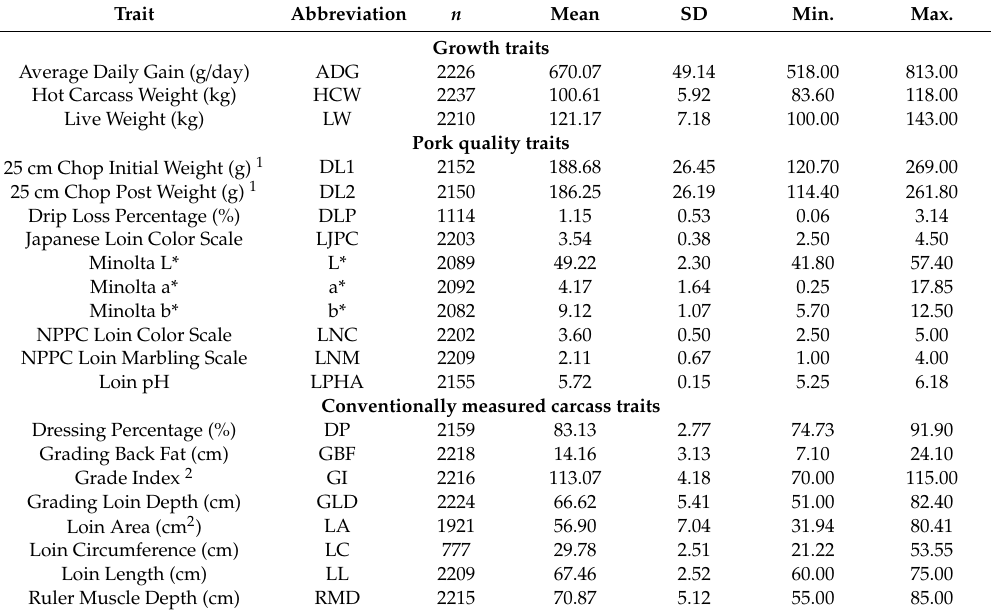
Table 1. Complete descriptive statistics for growth, pork quality and conventionally measured carcass traits.